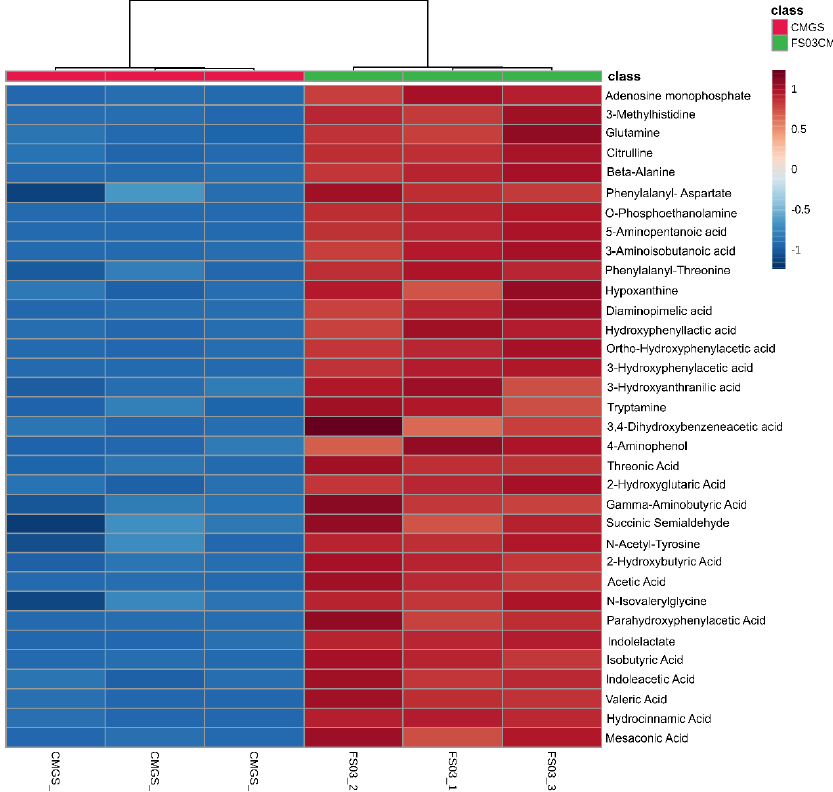
Figure 3. Peak pair ratio of positively identified metabolites (with tier 1 identification confidence). Heatmap shows positively identified metabolites with their abundance in FS03CM and CMGS groups. Rows represent positively identified metabolites, whereas columns represent replicates (n = 3). The levels of metabolites are shown using a pseudo- color scale (from −1.0 to 1.0), with red representing high intensity levels and blue representing low intensity levels. CMGS (Cooked meat glucose starch medium); FS03CM-conditioned medium prepared from FS03.